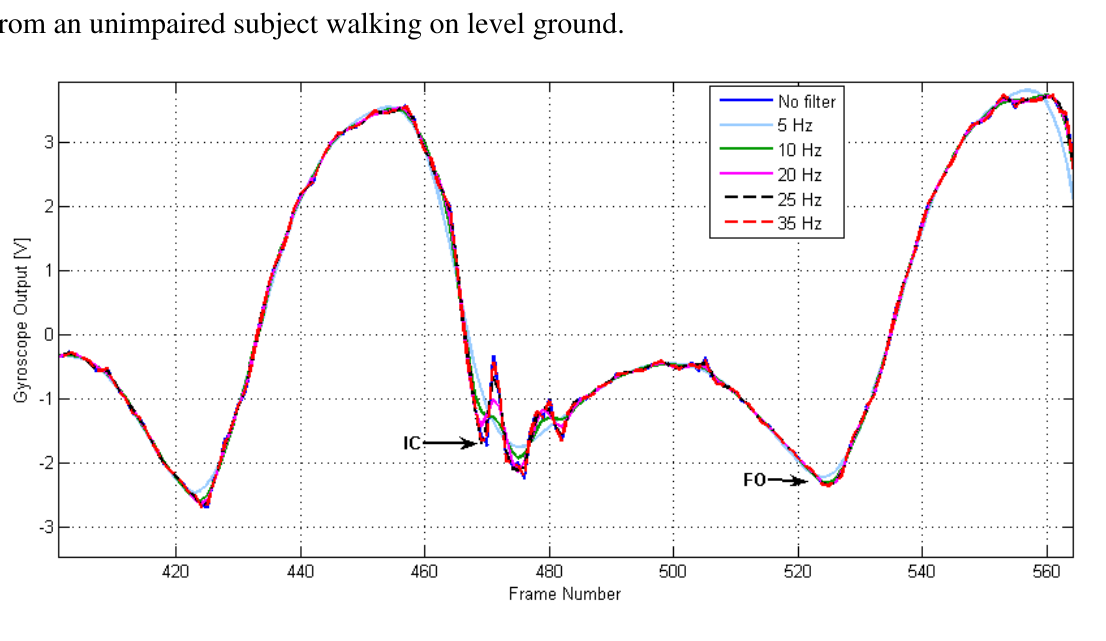
Figure 2. The effect of different cut off frequencies on the detection of IC. The data corresponds to an unimpaired subject walking on level